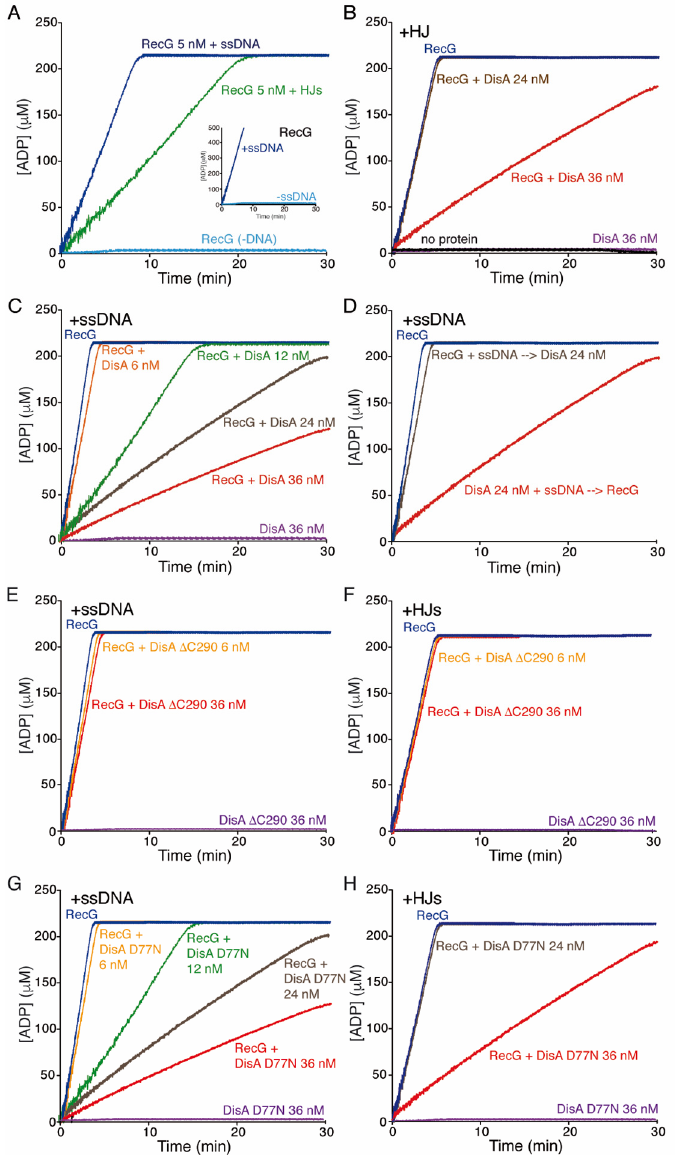
Figure 4. DisA inhibits the ATPase activity of RecG. ( A ) RecG (5 nM) was incubated with or without 3199-nt cssDNA or HJ-3 DNA (10 µ M in nt) in buffer D containing 5 mM ATP and the ATP regeneration system, and the ATPase activity was measured for 30 min. Insert, RecG (15 nM) was incubated with cssDNA in buffer D containing 5 mM ATP and 2x the ATP regeneration system, and the ATPase activity was measured for 30 min. ( B ) HJ-J3 DNA was incubated with RecG (15 nM), DisA (24–36 nM) or both in buffer D containing 5 mM ATP and the ATP regeneration system and the ATPase activity measured for 30 min. ( C ) cssDNA was incubated with RecG (15 nM), DisA (6–36 nM) or both proteins and the ATPase activity was measured. ( D ) cssDNA was pre-incubated with RecG (15 nM) or DisA (24 nM) (5 min at 37 ◦ C), then DisA (RecG + ssDNA → DisA) or RecG (DisA + ssDNA → RecG) was added and the ATPase activity was measured. ( E to H ) cssDNA ( E , G ) or HJ-3 DNA ( F , H ) was incubated with RecG (15 nM) and DisA ∆ C290 (6–36 nM) ( E , F ) or with RecG (15 nM) and DisA D77N (6–36 nM) ( G , H ) and the ATPase activity was measured. All reactions were repeated three or more times with similar results, and a representative graph is shown